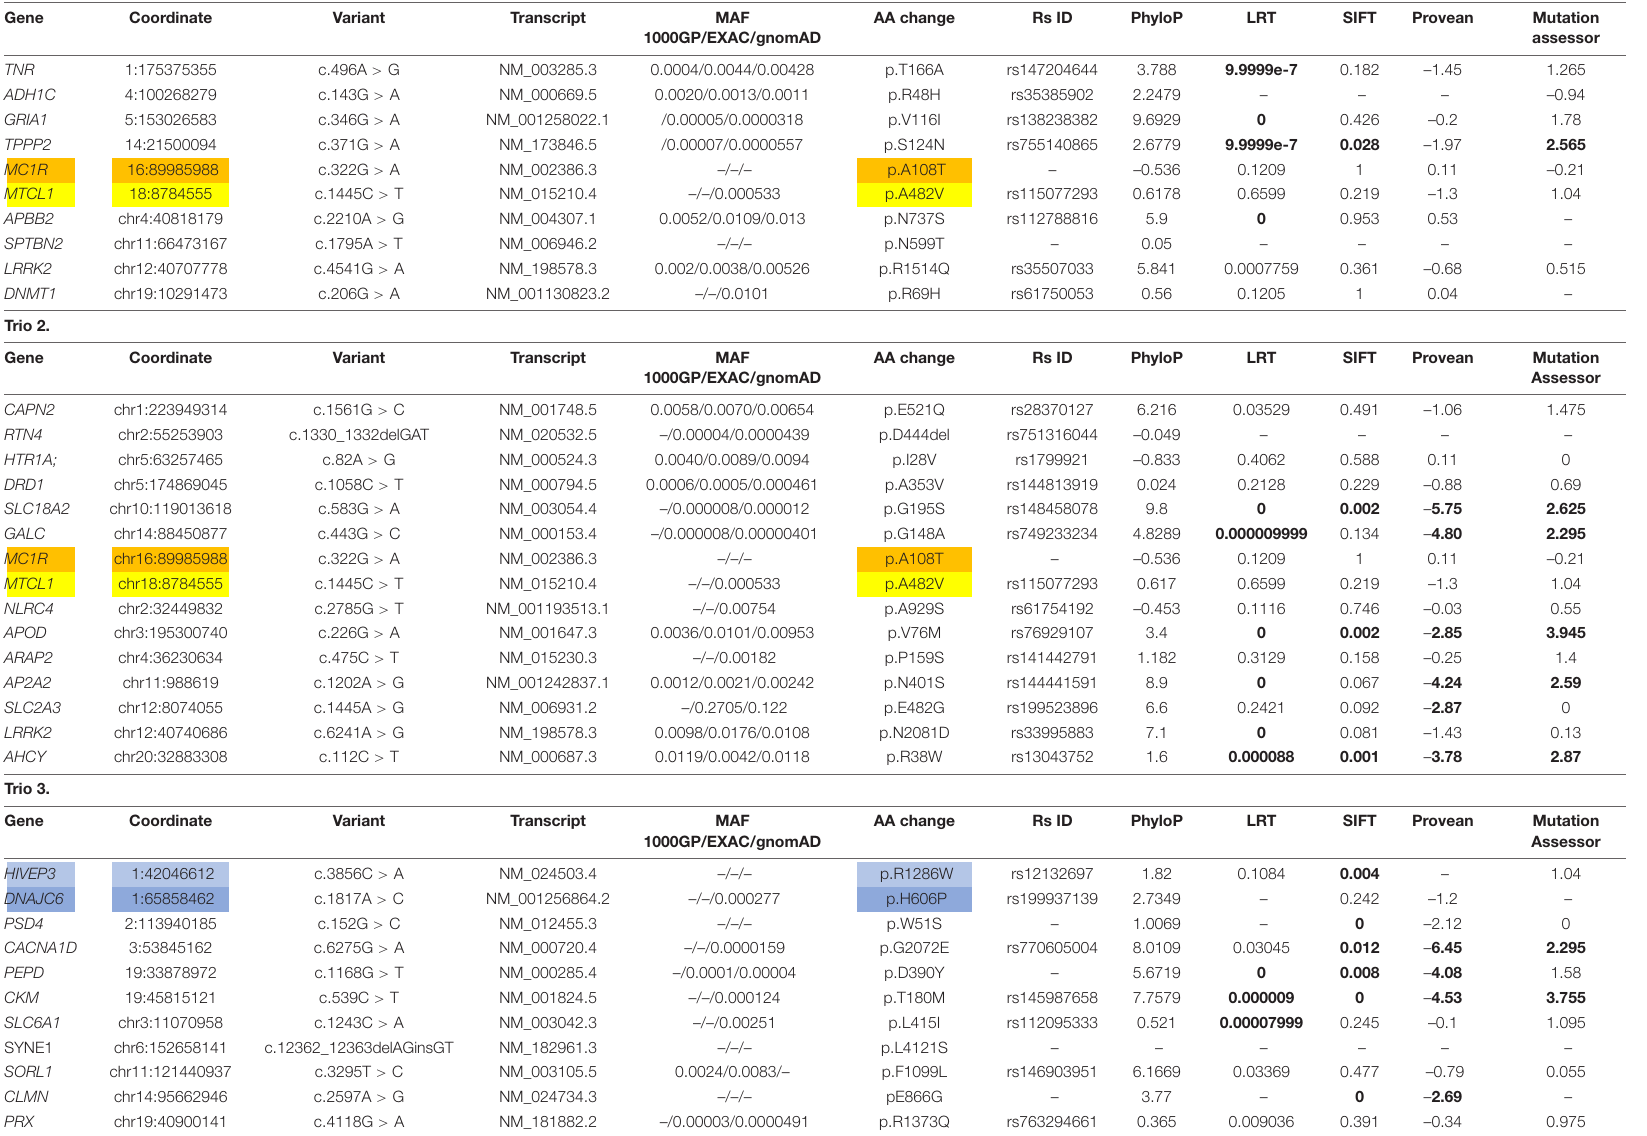
TABLE 4 | Found variants in individual trios. Trio